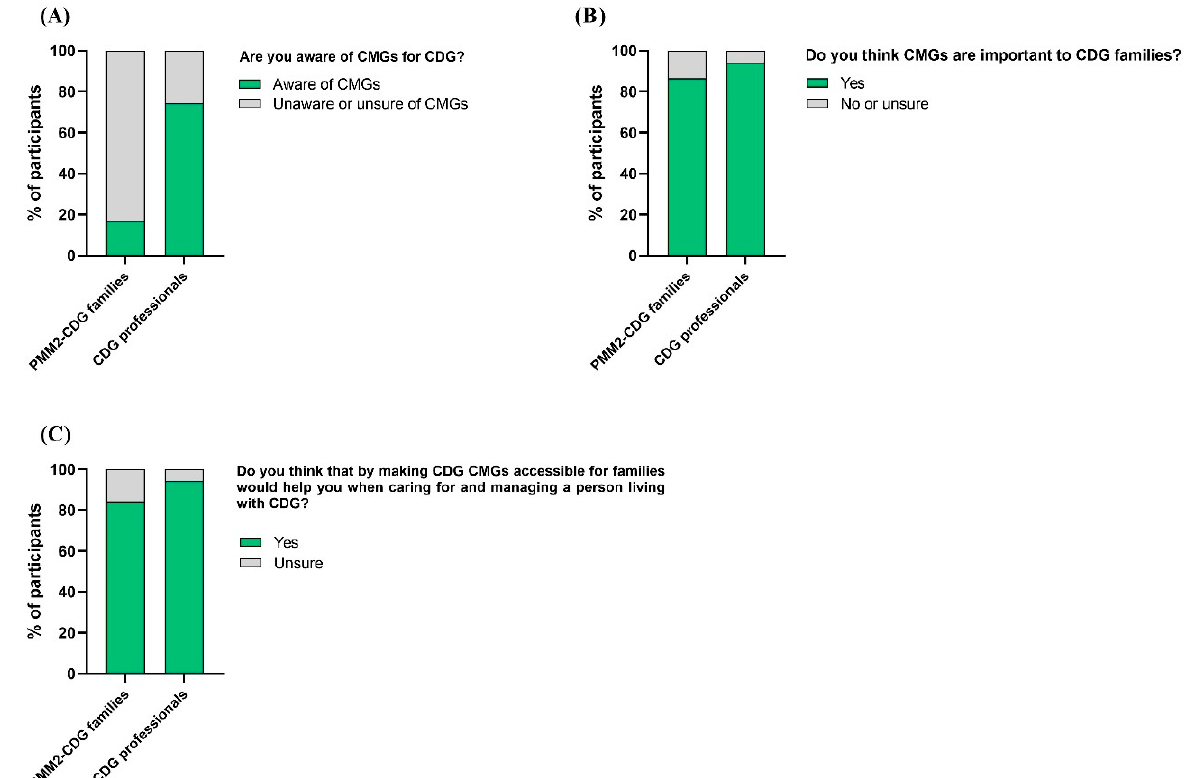
Figure 4. CMG recognition, perceived importance, and usefulness by CDG family and professional participants. ( A ) Families and professionals’ awareness of CMGs; ( B ) families and professionals attributed importance to CMGs; ( C ) CMG perceived usefulness by families and professionals in the care and management of CDG.